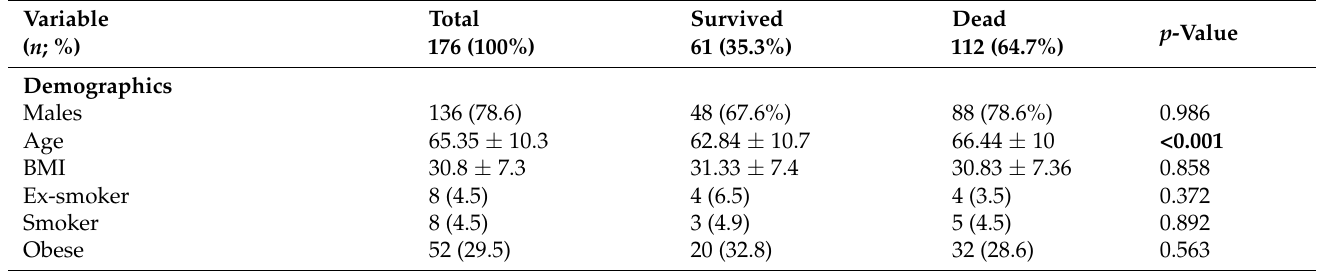
Table 1. Demographic and general characteristics of COVID-19 ICU patients with